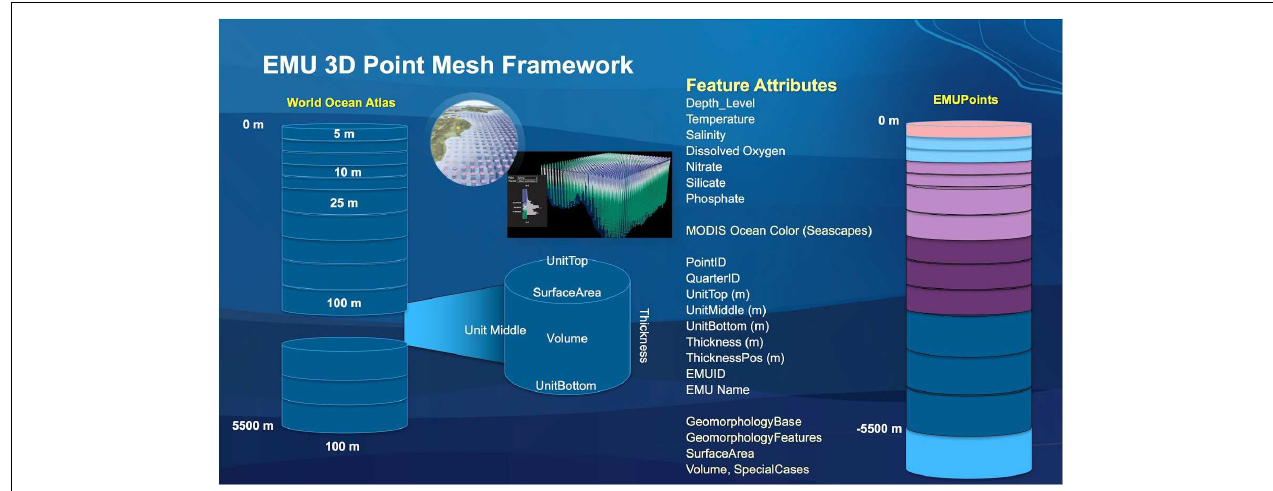
FIGURE 4 | The EMU is comprised of a global point mesh framework, created from the NOAA World Ocean Atlas. Each point includes attributes of chemical and physical oceanographic structure that are likely drivers of many ecosystem responses.